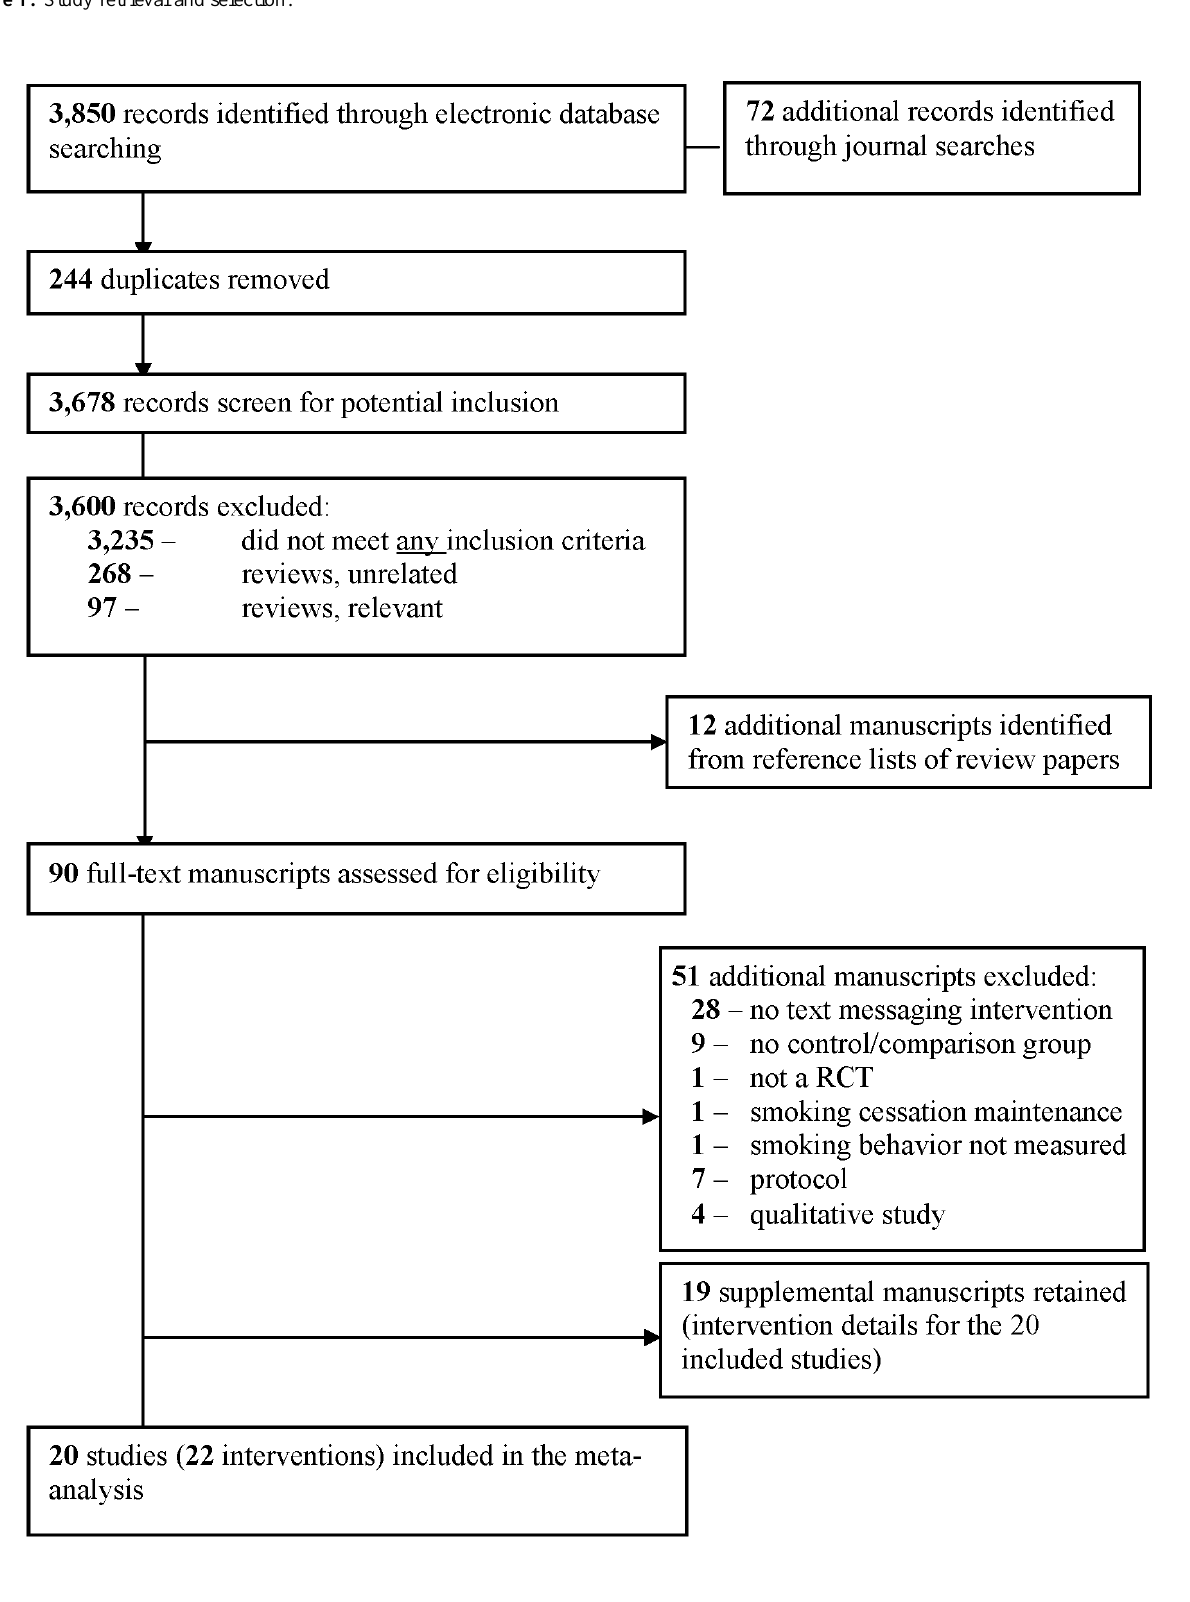
Figure 1. Study retrieval and